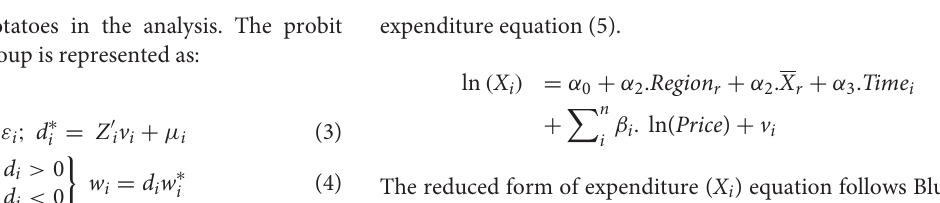
FIGURE 1 | Average weekly consumption of fresh and processed potatoes in the UK. Source: Own elaboration based on DEFRA’s data (7).